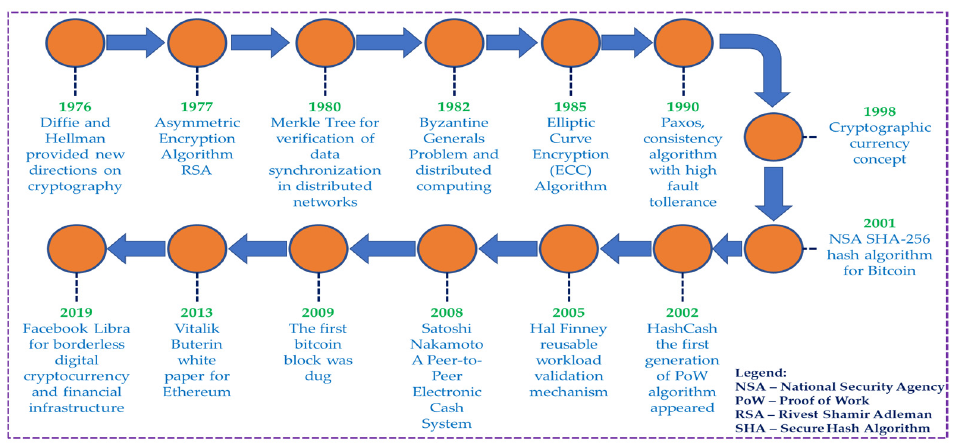
Figure 3. Historical evolution of blockchain: key milestones .